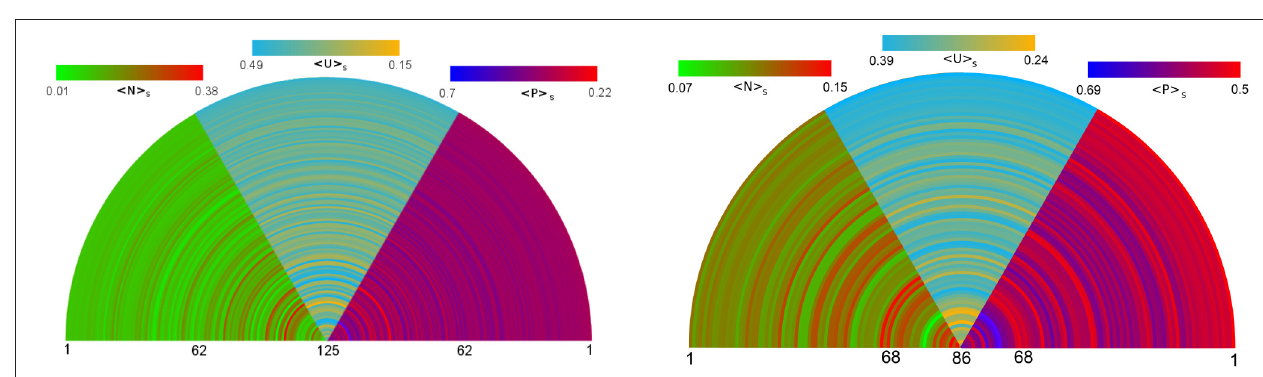
FIGURE 10 | Representation of the average emotional expression of the nodes of each k-shell, for EP left and for DY right. Each circle represents the nodes with a particular k-shell number, with a distance from the center inversely proportional to their coreness. Circles are colored in three intervals according to h N i s , h U i s , and h P i s , ranging from minima to maxima as indicated by the color bars.